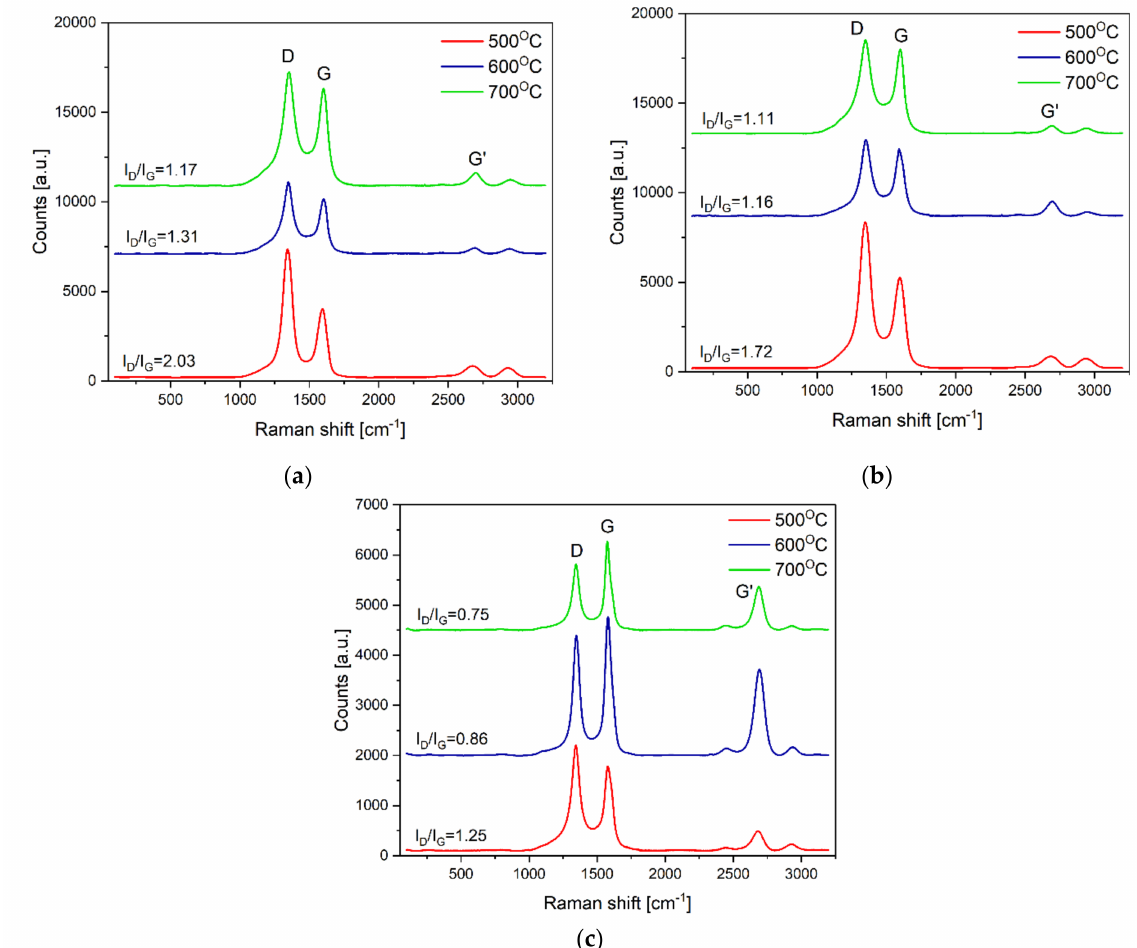
Figure 14. Raman spectra of Ni 3 Al foils’ surface after decomposition of ethanol: ( a ) without water vapour (mixture #1) and with water vapour addition: ( b ) 0.17 wt.% (mixture #2) and ( c ) 1.1 vol.% (mixture